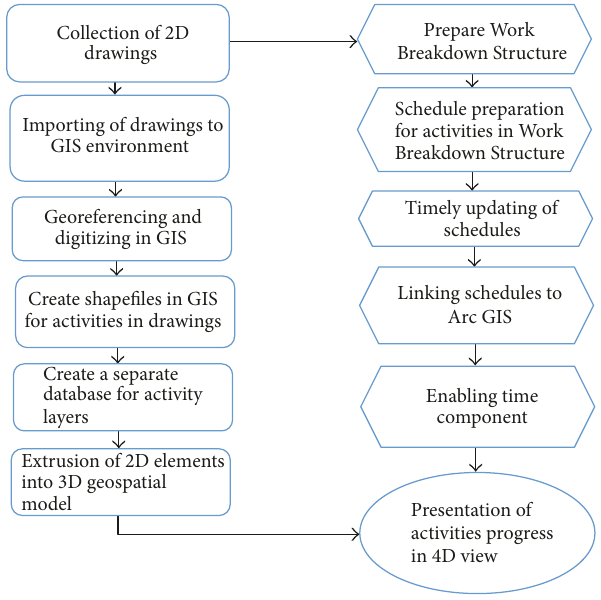
Figure 1: Flowchart for the model development of 4D